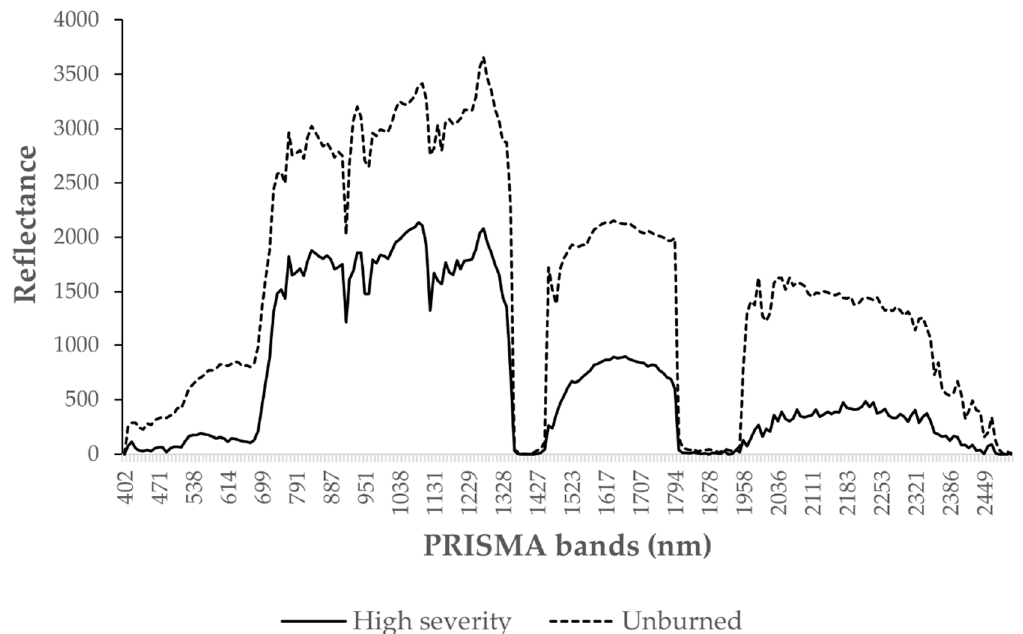
Figure 15. PRISMA scene spectral differences between high-severity areas and unburned parcels. The aim of the image is to represent the difference in extreme scenarios. Spectral signatures vary within the same observed categories.